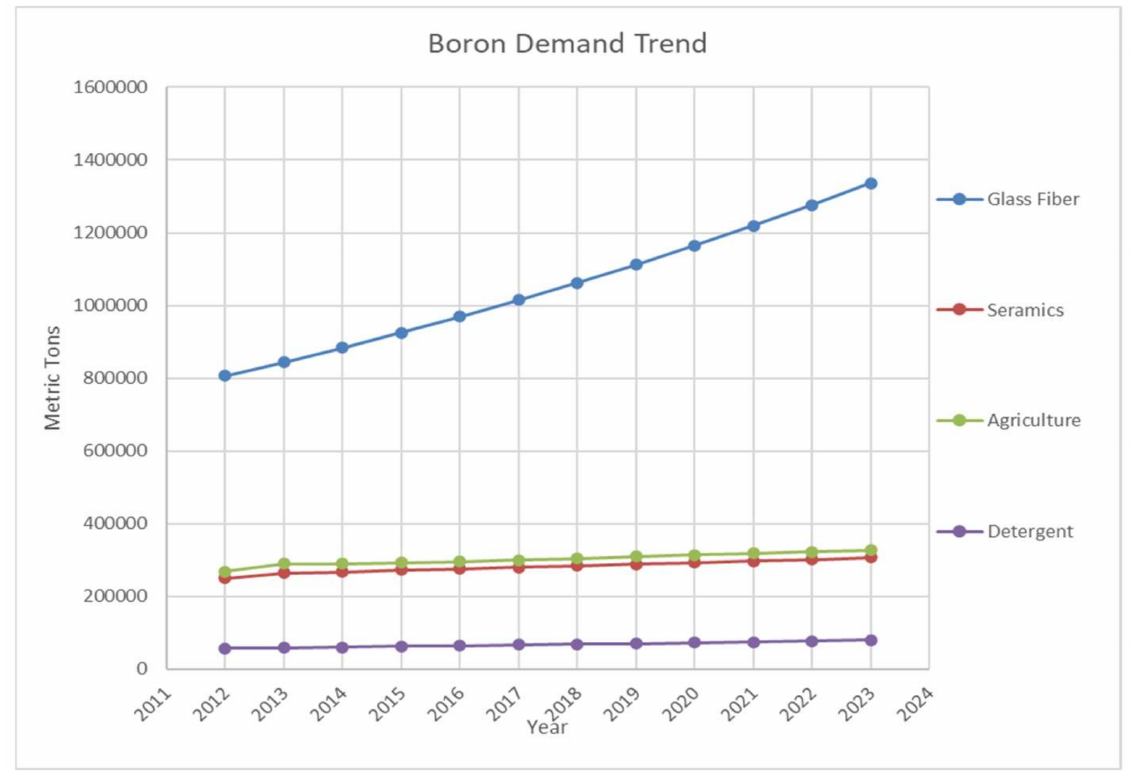
Figure 6. World demand for boron